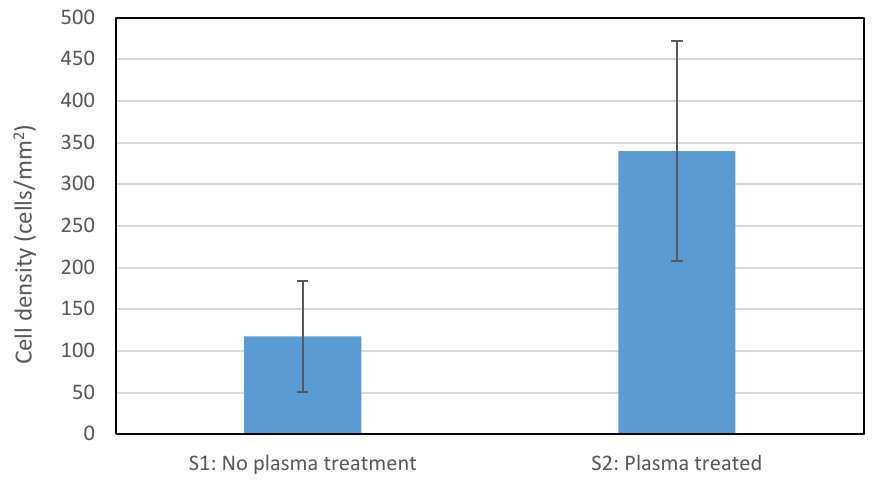
Figure 8. Fibroblast cell density on conductive scaffolds after 7 days.